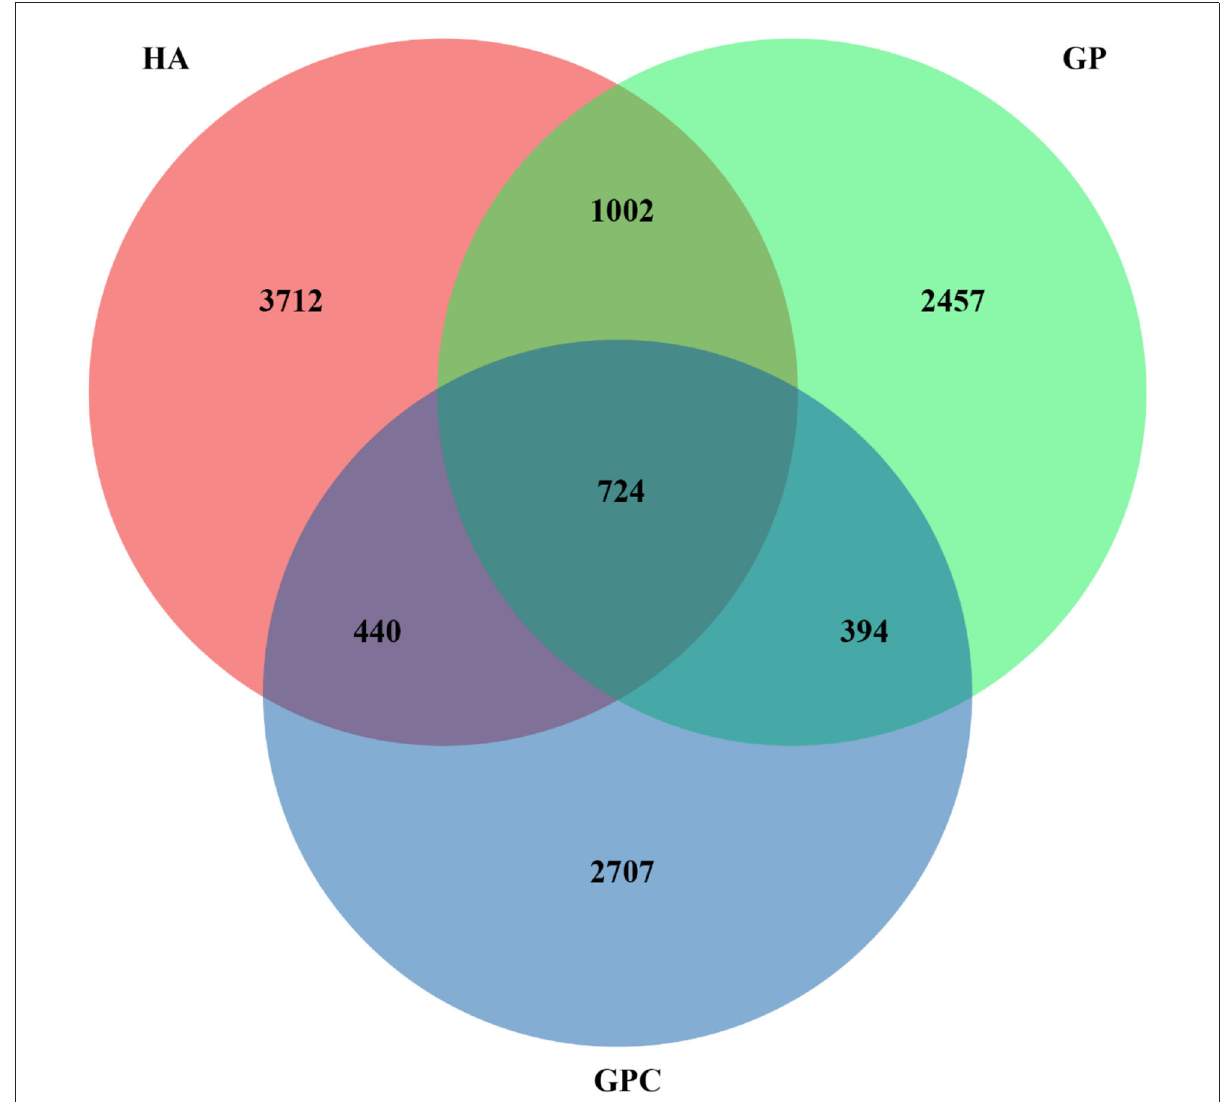
FIGURE1 Venn diagram representing the common and unique OTUs found at each diet ( n = 6). HA, non-pelleted native grass hay diet, GP, pelleted native grass hay diet; and GPC, pelleted native grass hay with concentrate